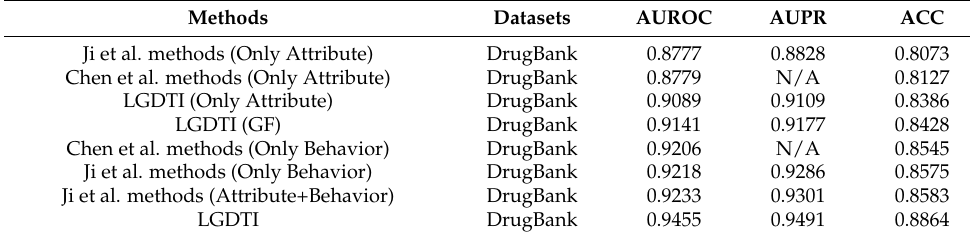
Table 4. Compared with existing state-of-the-art prediction methods.